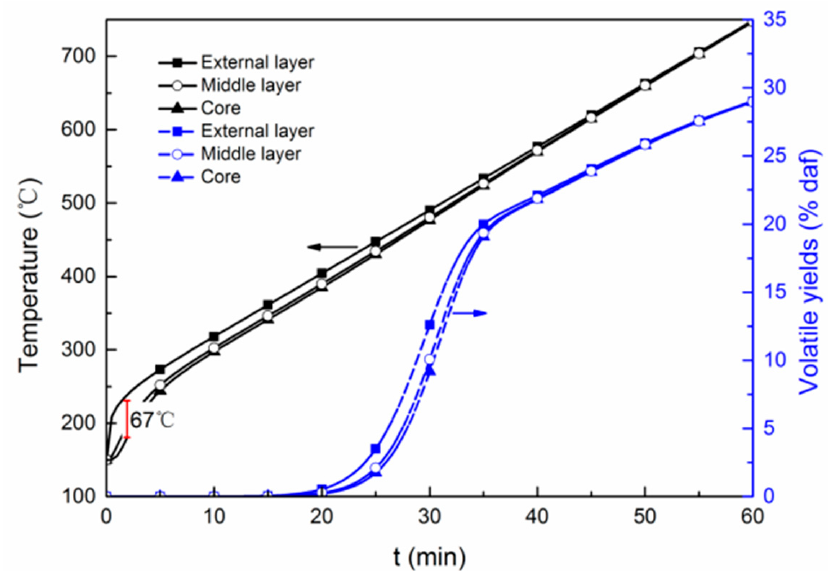
Figure 2. Temperature variation and volatile yield in the different regions of the coal particle with a diameter of 20 mm.